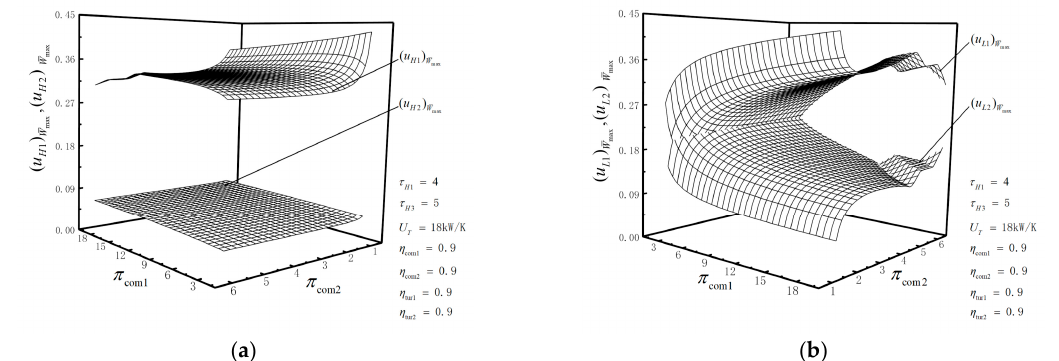
π and ( ) ( ) u and u versus Figure 5. ( a ) Relationships of Figure 5. ( a ) Relationships of ( u H 1 ) and ( u H 2 ) versus π com1 and π com2 ; ( b ) relationships of com1 WH WH W max W max max 1 max 2 π and π . ( u ) and ( u L 2 ) versus π com1 and π com2 . Energies 2020 , 13 x FOR PEER REVIEW u and u versus ( ) ( ) L 1 W max W max com1 com2 WL WL max 1 max 2